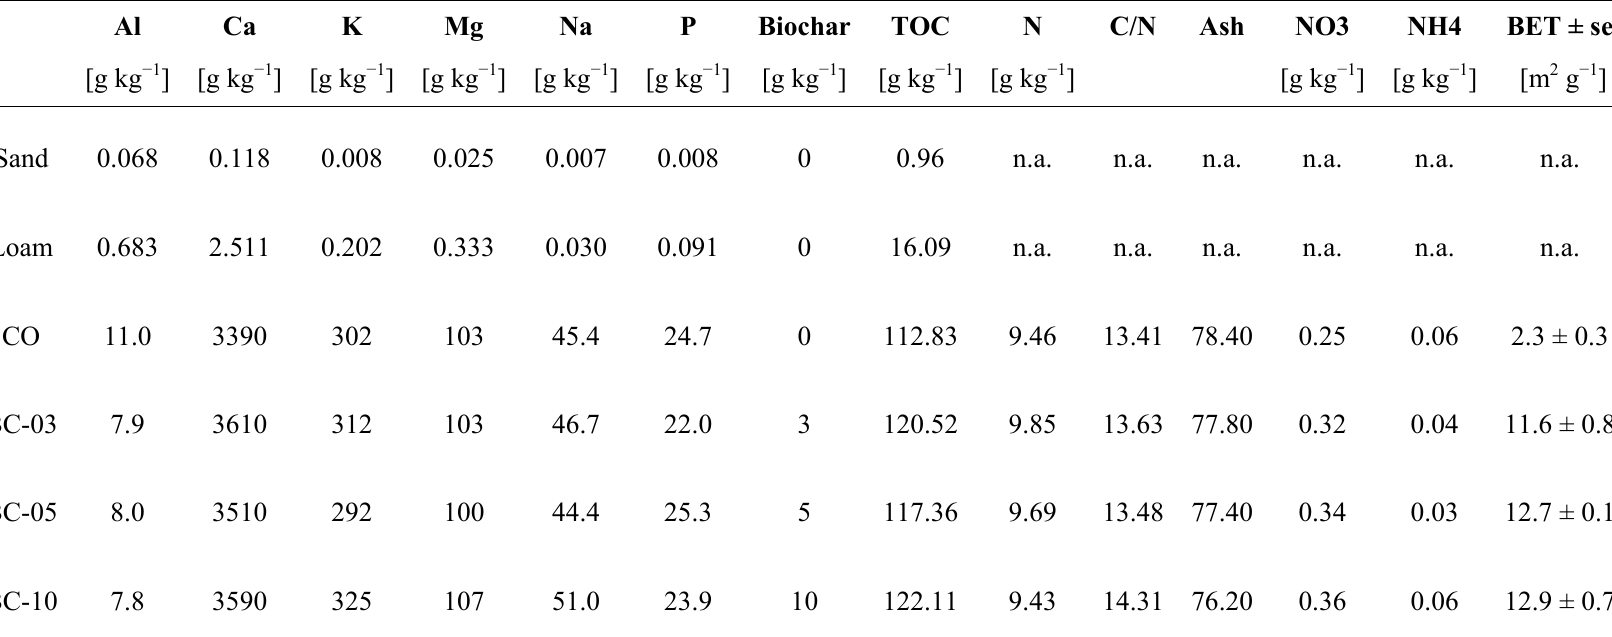
Table 1. Chemical composition of the two soil substrates and the biochar composts are shown. ―CO‖ is compost without biochar. The number following ―BC-‖ denotes the approximate fraction of biochar in the composted product as ―kg biochar per Mg‖. ―n.a.‖ means not analyzed. ―BET‖ is BET surface area, ―±se‖ means plus minus standard error ( n =